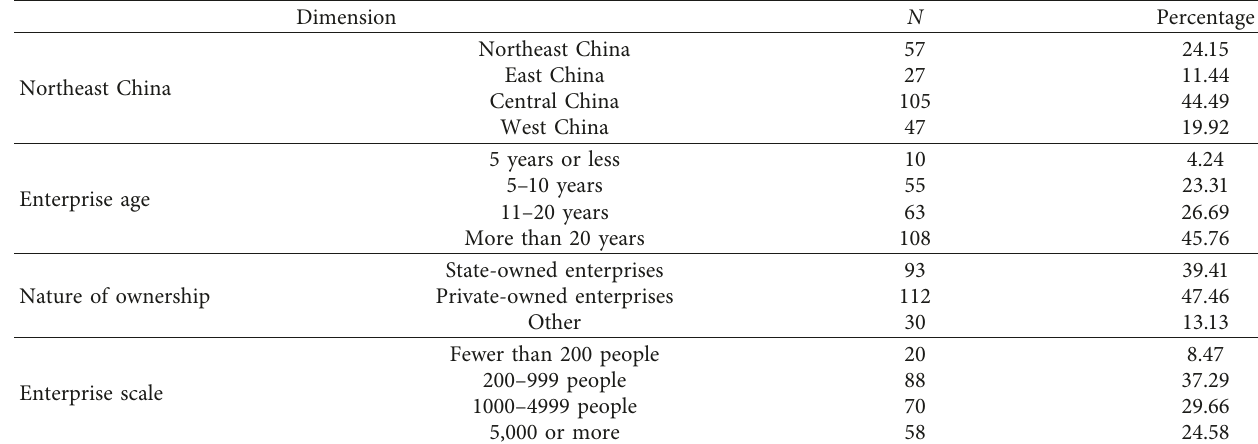
Table 2: A statistical description of the characteristics of sample enterprises.